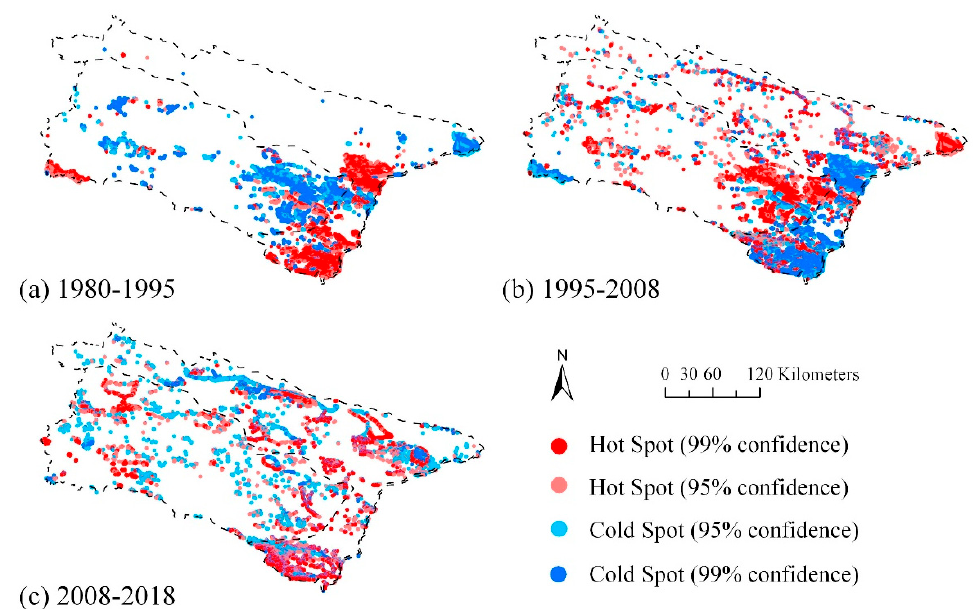
Figure 6. Hotspot of the total ESV change for ( a ) 1980–1995, ( b ) 1995–2008, and ( c ) 2008–2018.